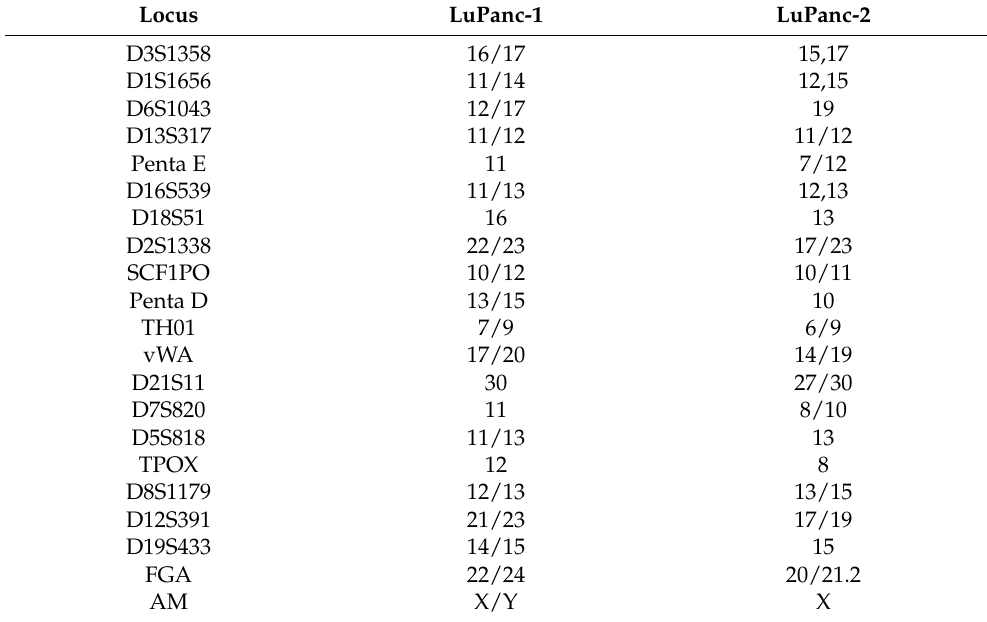
Table 1. Short tandem repeat analysis.